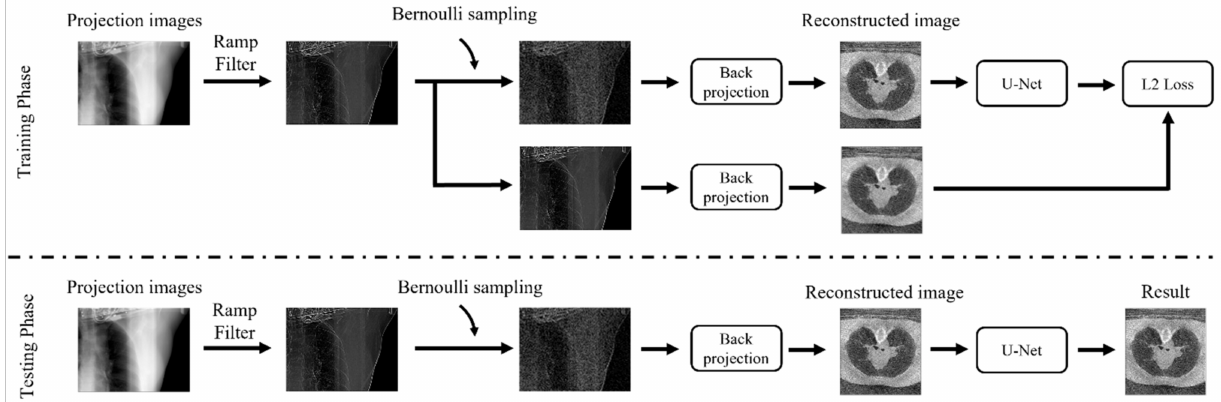
Figure 3. Flowchart of the proposed method with the dropped projection strategy ( DPS ). In the training phase, we map each slice of the reconstructed image (reconstructed using dropped projection images) to each slice of the reconstructed image (reconstructed by non-dropped projection